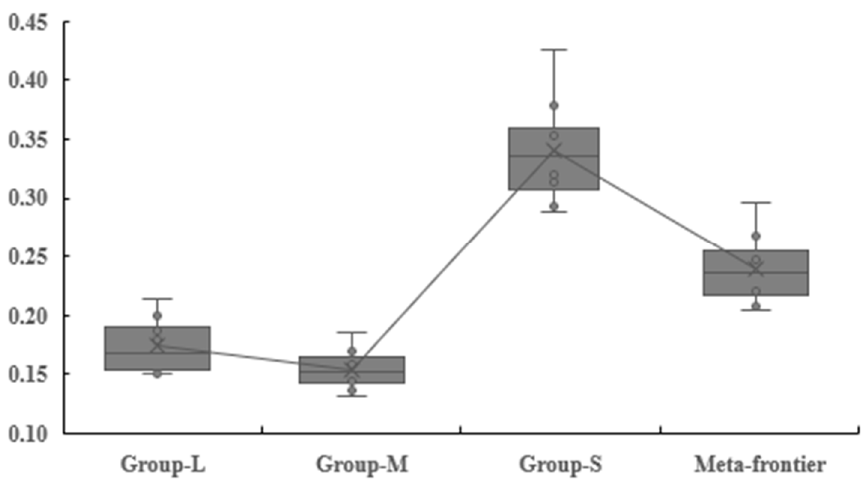
Figure 2. Energy intensity distribution of the different groups.